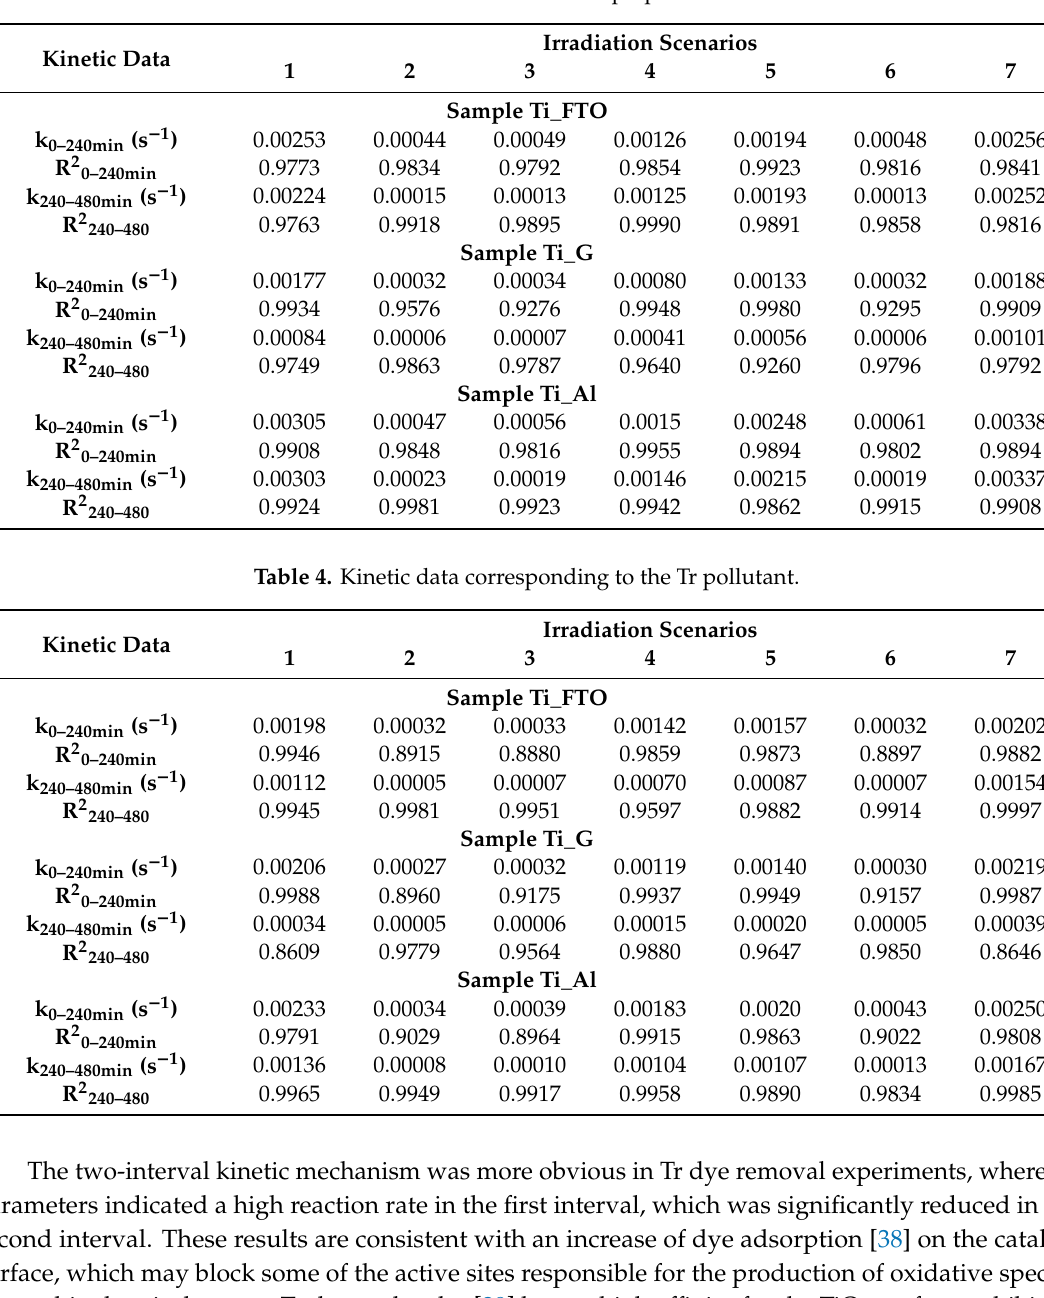
Table 3. Kinetic data for the Apd pollutant.